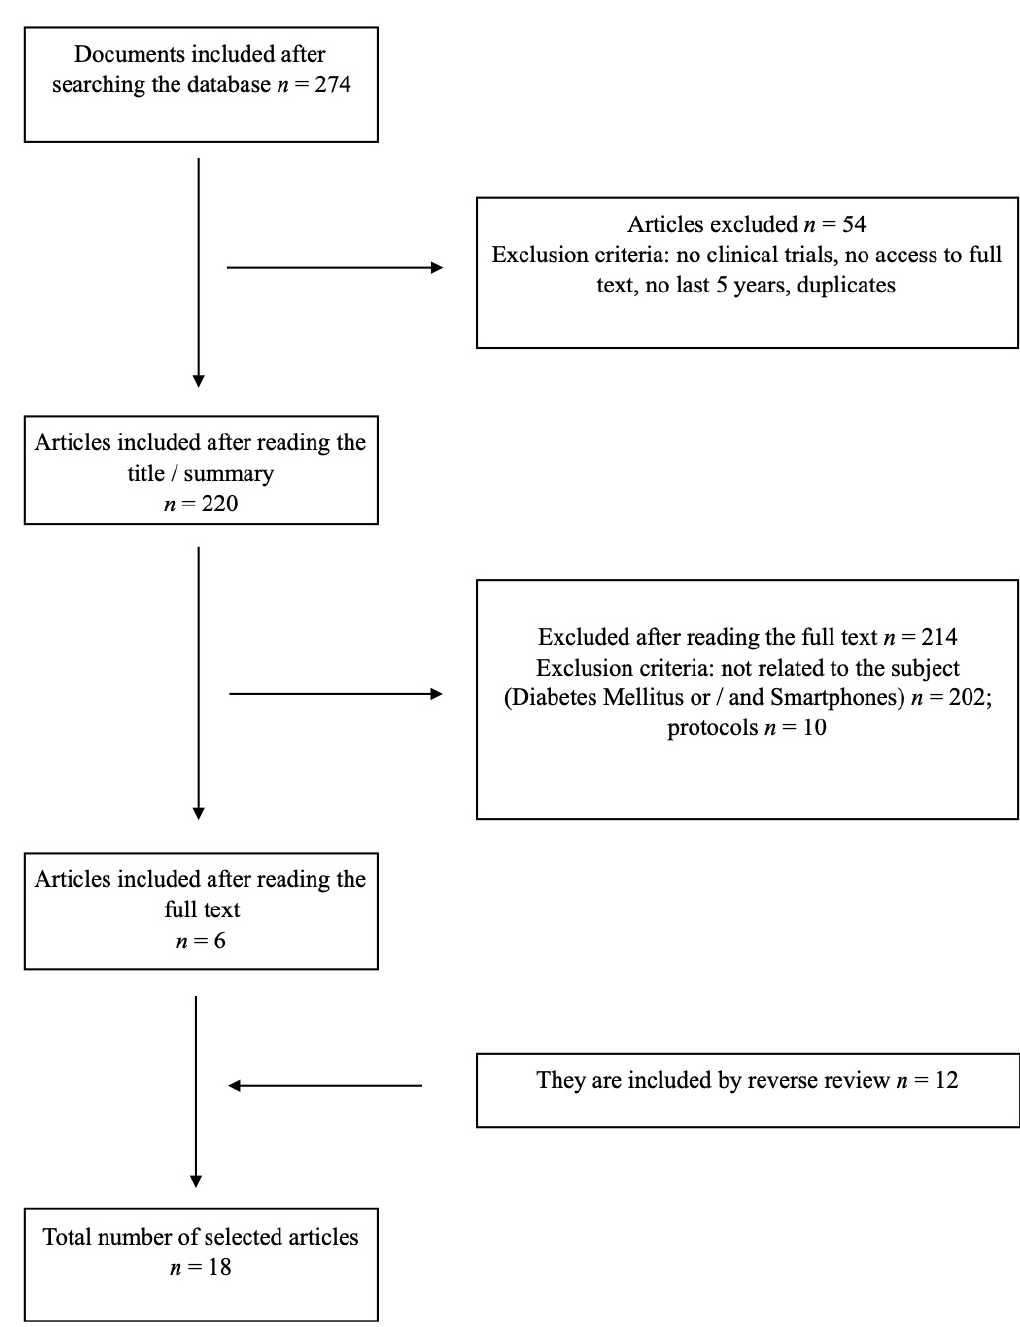
Figure 1. Flowchart of the study selection process.